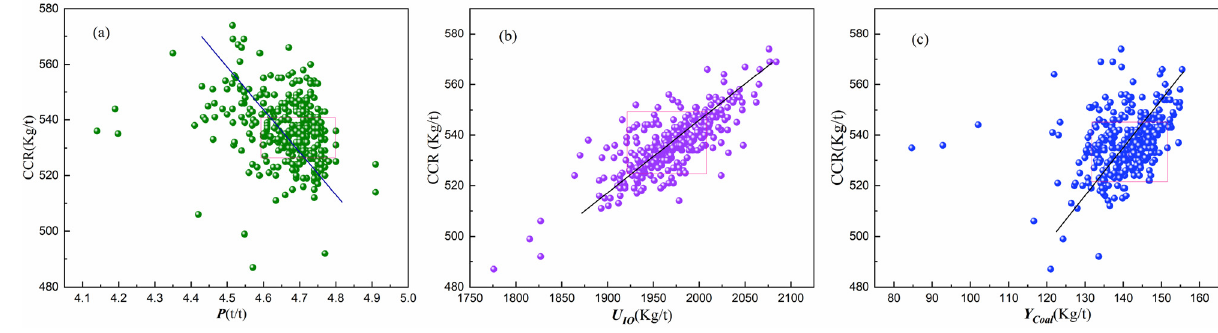
Figure 4: Relationships between the top three most important features: ( a ) P , ( b ) U IO , and ( c ) Y Coal and CCR.